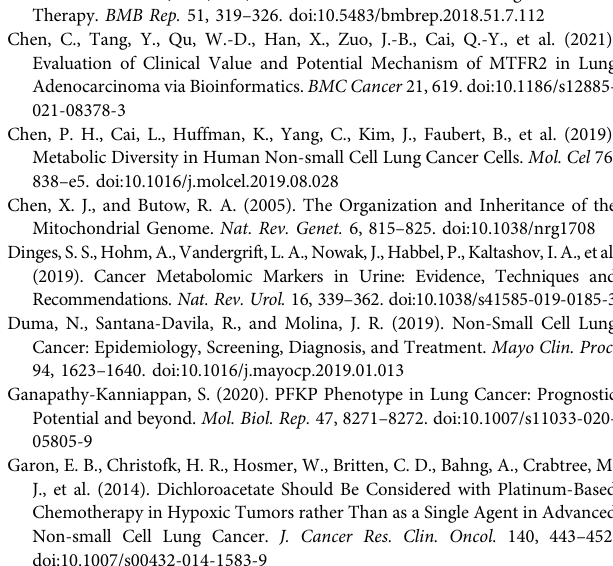
Supplementary Figure S1 | Volcano plot of the mRNA expression of ETC- associated genes in the TCGA-LUAD dataset. Supplementary Figure S2 | Heatmap of differential metabolites in WT-FDX1 and KD-FDX1 cells in the positive ion mode. Supplementary Figure S3 | Correlation between FDX1 expression and immune in fi ltrates in